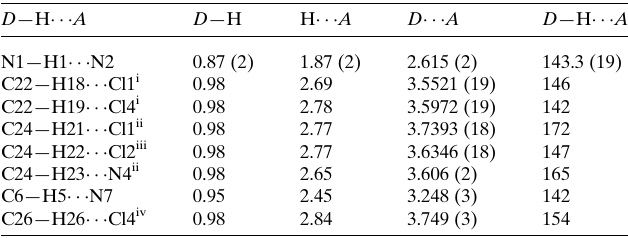
Table 1 Hydrogen-bond geometry (A˚ , (cid:5) ).